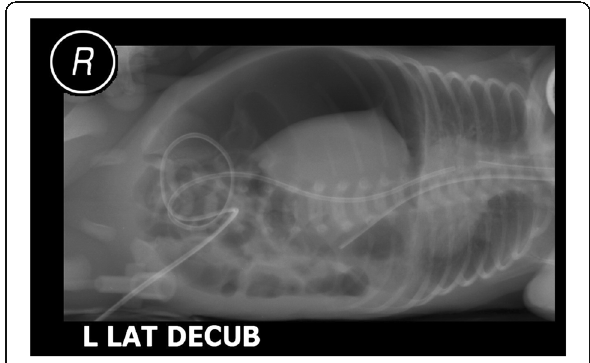
Fig. 1 A plain lateral decubitus x ray of the abdomen showing massive pneumoperitonium with no evidence of pneumatosis intestinalis and no portal venous